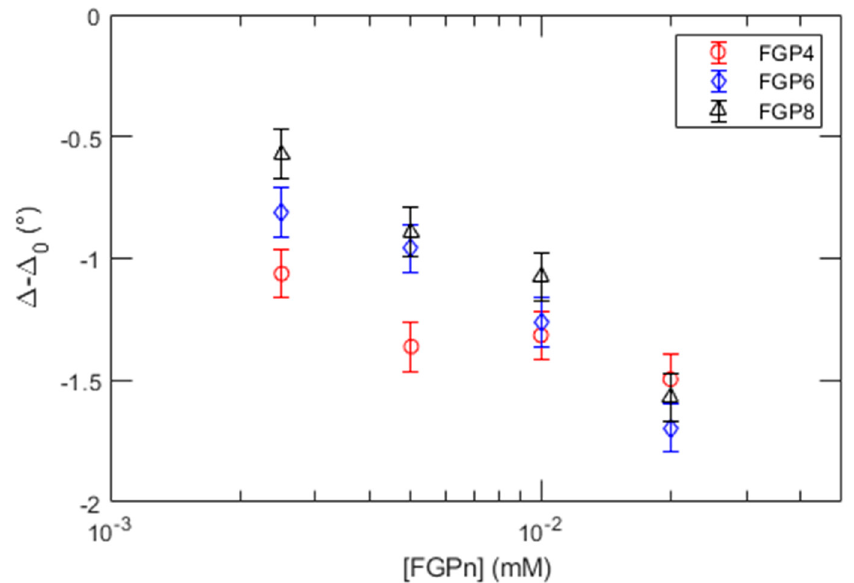
Figure 7. The variation of the ellipsometric phase angle ∆ as a function of surfactant concentration, after 2 h of incubation, for the three surfactant molecules studied. Note the semilogarithmic scale. A first estimate can be drawn based on the molecular structure: FGPs molecules contain two types of units, fluorinated and hydrogenated. Fluorinated alkyl chains,